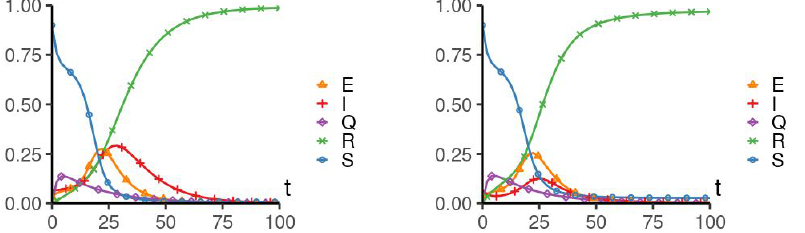
Figure 14. Experiment 2. Sum of the fractions of all levels: uncontrolled ( left ) and controlled cases ( right ).